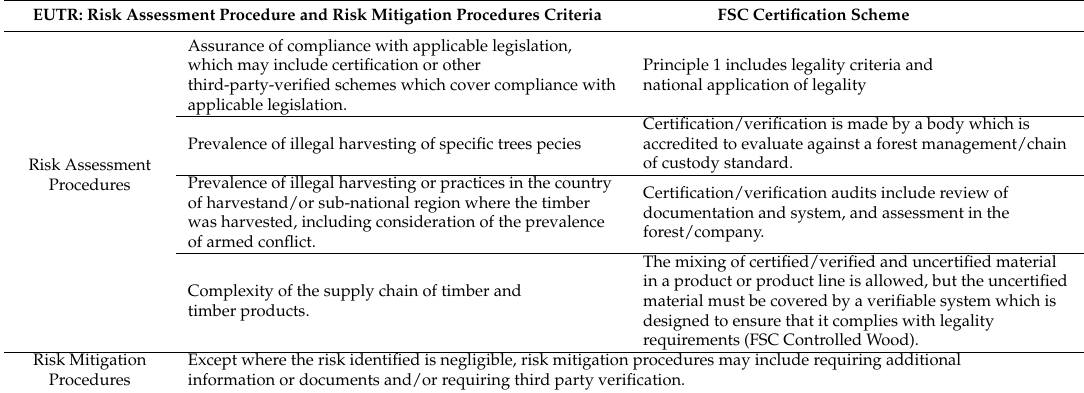
Table 1. Elements of EUTR covered by the FSC certification scheme.